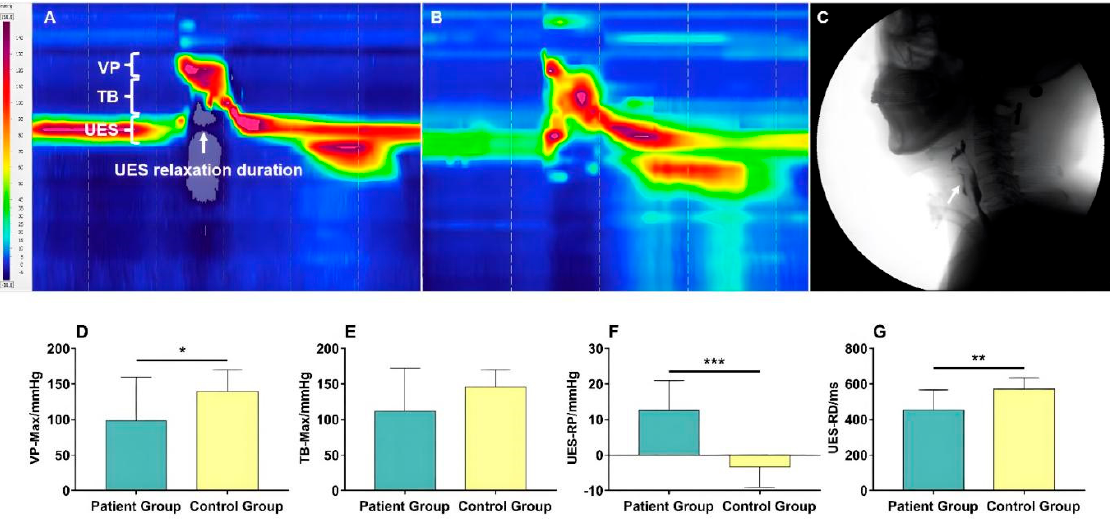
Figure 2. Comparison of the biomechanics characteristics between the patient group and control group: ( A ) Time–space chart of HRM in a healthy participant (white arrow, the UES relaxation du-